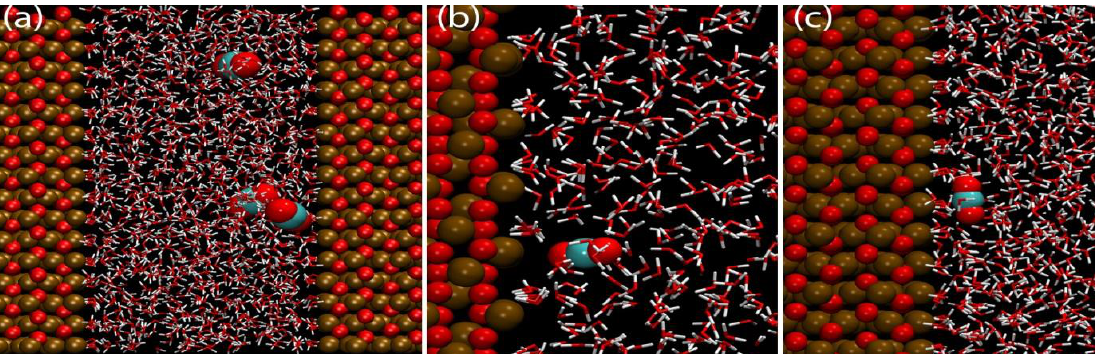
Figure 9. Snapshots of various configurations of trapped ( b , c ) and directly adsorbed CO 2 on a Calcite surface at 274 K. Red on calcite is oxygens and brown is calcium, but upscale relative to size of water. CO 2 is upscale, with red for oxygens and cyan for carbon. Water molecules have white hydrogens and red oxygens. The average value of CO 2 chemical potential is − 39.21 kJ/mole.